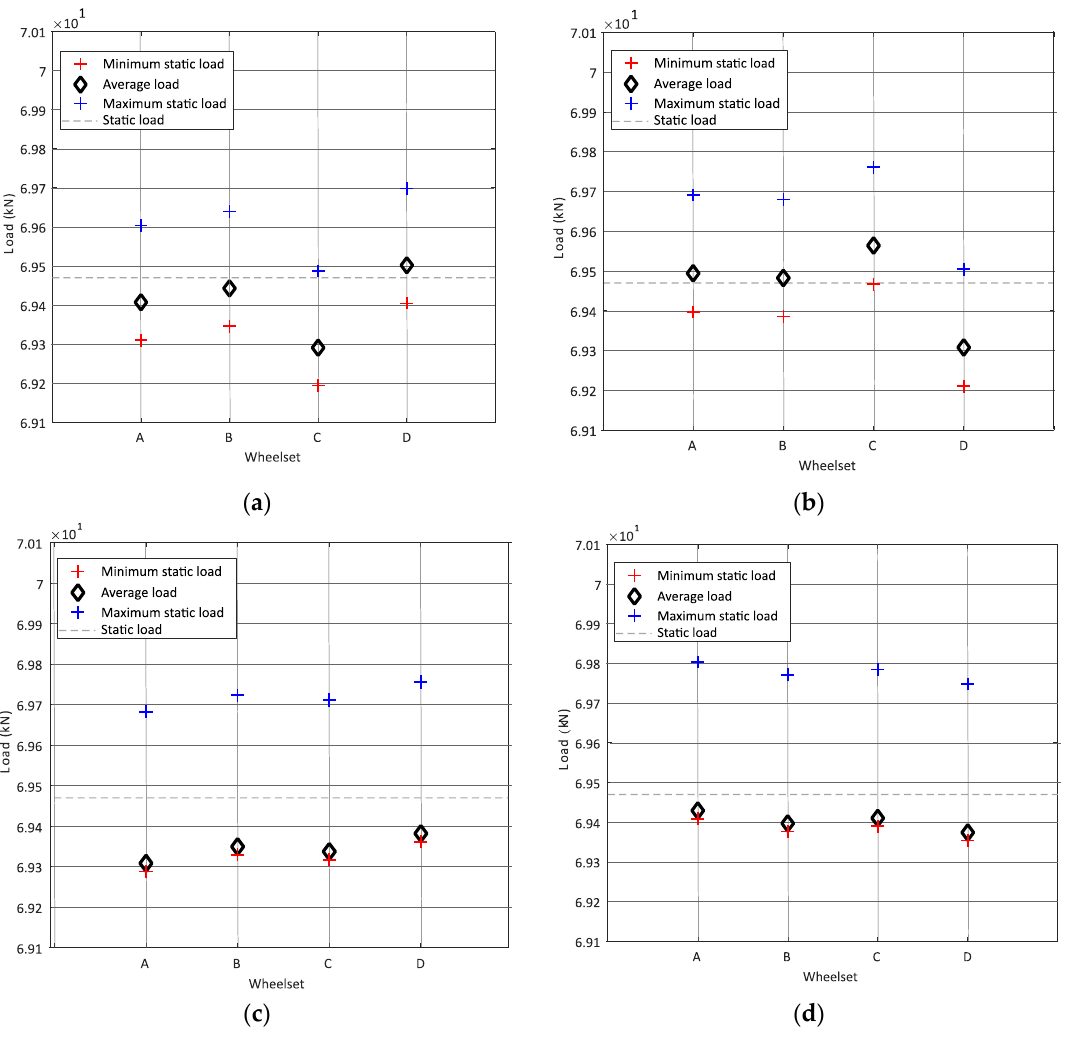
Figure 13. Interval of static loads for ( a ): speed = 10 m/s considering unevenness profile 1, ( b ): speed = 10 m/s considering unevenness profile 2, ( c ): speed = 20 m/s considering unevenness profile 1, ( d ): speed = 20 m/s considering unevenness profile 2.